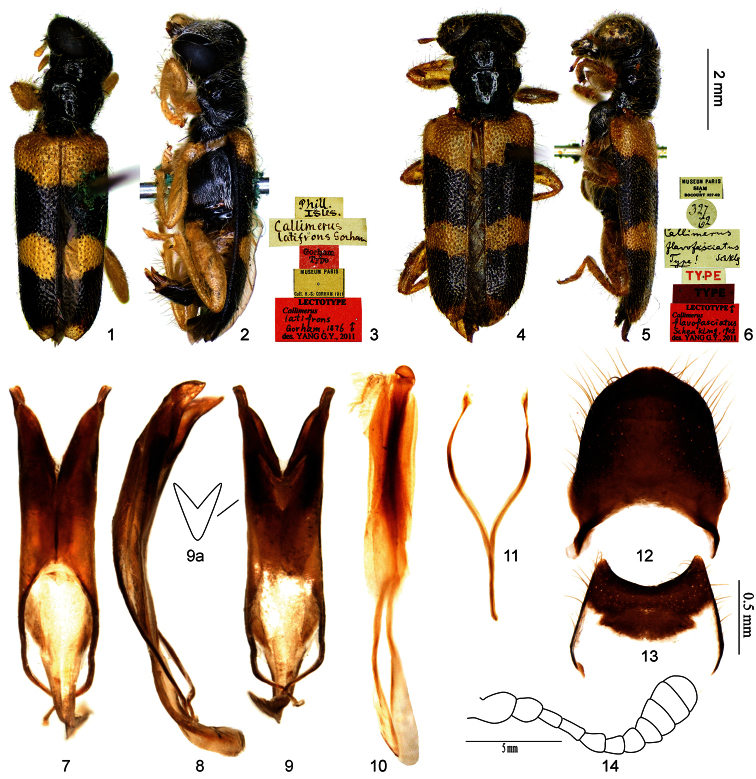
Callimerus latifrons Gorham, 1876. 1–3 lectotype of Callimerus latifrons Gorham, 1876 (1 dorsal view 2 mirror image of right lateral view 3 labels) 4–6 lectotype of Callimerus flavofasciatus Schenkling, 1902 (4 dorsal view 5 lateral view 6 labels) 7–13 male terminalia, specimen from Philippines 7–9 tegmen (7 dorsal view 8 lateral view 9 ventral view 9a outline of ventral membranous region) 10 phallus 11 spicular fork 12 tergite VIII 13 sternite VIII 14 antenna, specimen from Yunnan.